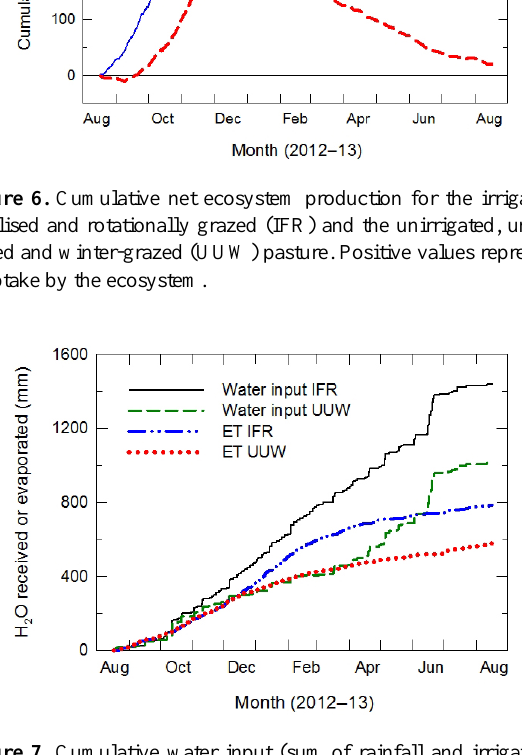
Figure 7. Cumulative water input (sum of rainfall and irrigation) and evapotranspiration (ET) for the IFR and UUW